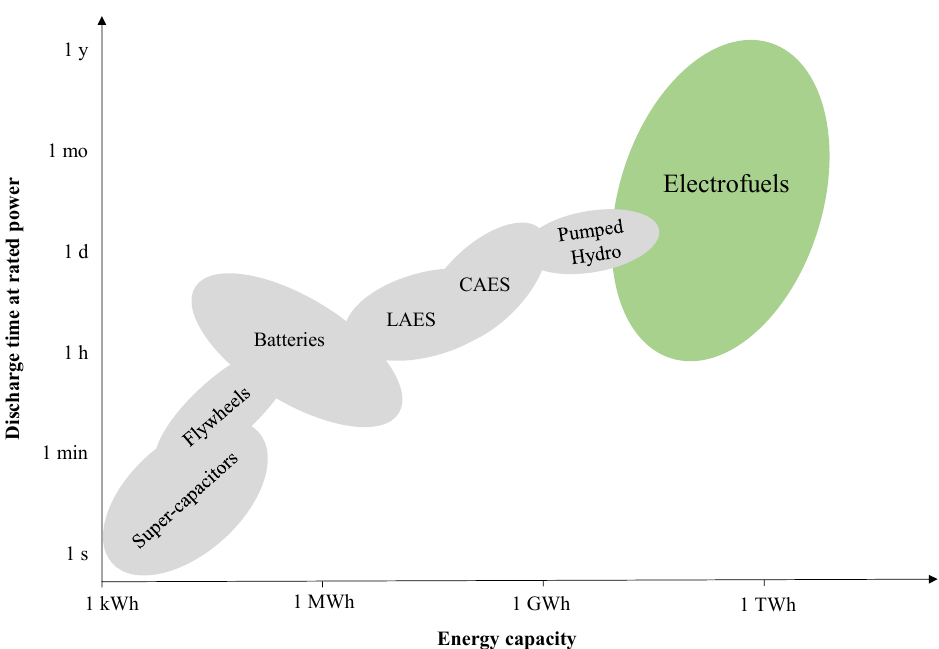
Figure 1. Mapping storage technologies according to performance characteristics (CAES = Com- pressed Air Energy Storage, LAES = Liquid Air Energy Storage). Data taken from [10].